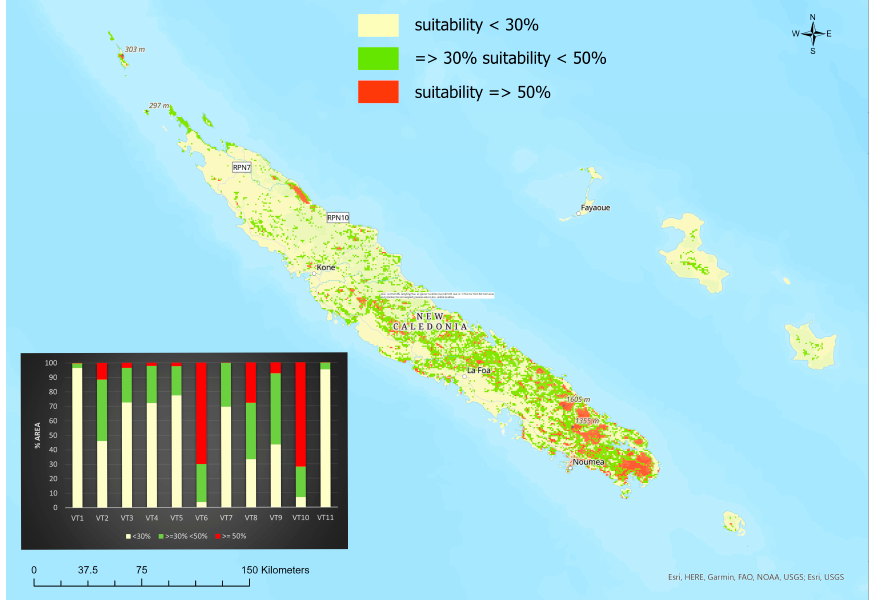
Figure 4. Habitat suitability of the genus Arsipoda in New Caledonia (map) and in each vegetation type (histogram).